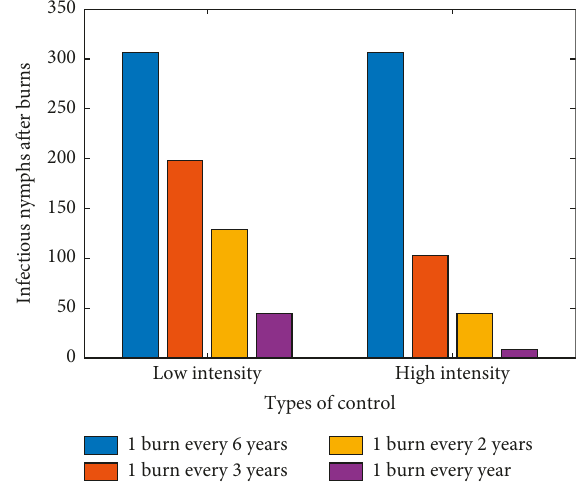
Figure 4: Simulation of varying intervals between burns, separated by their